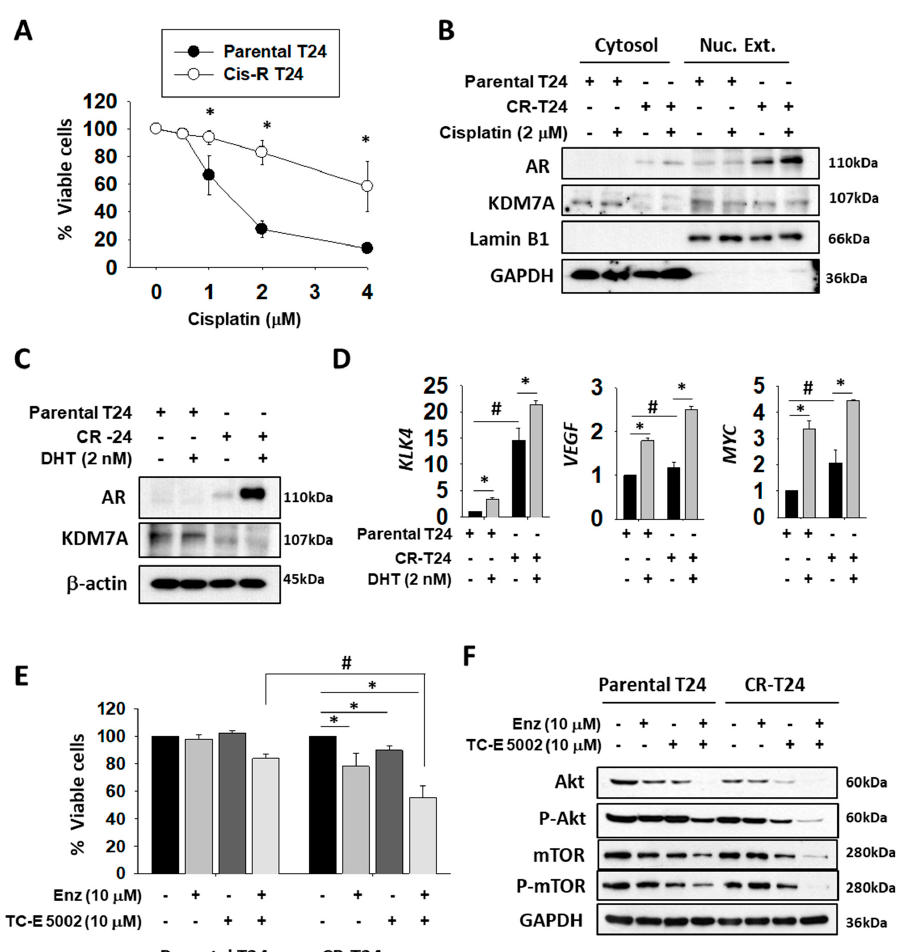
Figure 5. Nuclear localization and activity of AR were elevated in cisplatin-resistant T24 (CR-T24) cells, and treatment with enzalutamide and KDM7A inhibitor reduced the growth of CR-T24 bladder cancer cells. ( A ) Viability of parental and CR-T24 cells after treatment with the indicated concentrations of cisplatin for 3 days. Bars represent means ± SD of three independent experiments. * p < 0.05 (Student’s t -test) versus parental cells. ( B ) Western blots of the indicated proteins from parental and CR-T24 cells. The cytosolic and nuclear fractions from each cell line were extracted and blotted with the indicated antibodies. Lamin B1 immunostaining served as the nuclear protein loading control and GAPDH immunostaining as cytoplasmic control. ( C ) Western blots of AR and KDM7A proteins from parental and CR-24 cells, before and after 5 α -dihydrotestosterone (DHT) treatment. ( D ) mRNA levels of the indicated genes were measured from parental and CR-T24 cells. Bars represent means ± SD of three independent experiments. * p < 0.05 (Student’s t -test), versus the mock-treated group. # p < 0.05 (Student’s t-test) versus parental T24 cells. ( E ) Cell viability changes after 3 days of treatment with the indicated drugs on parental or CR-T24 cells. Bars represent means ± SD of three independent experiments. * p < 0.05 (Student’s t -test) versus the mock-treated group. # p < 0.05 (Student’s t -test) versus parental T24 cells. ( F ) Levels of the indicated proteins were measured from whole cell extracts of parental and CR-T24 cells, treated with either enzalutamide and/or TC-E 5002 for 2 days.